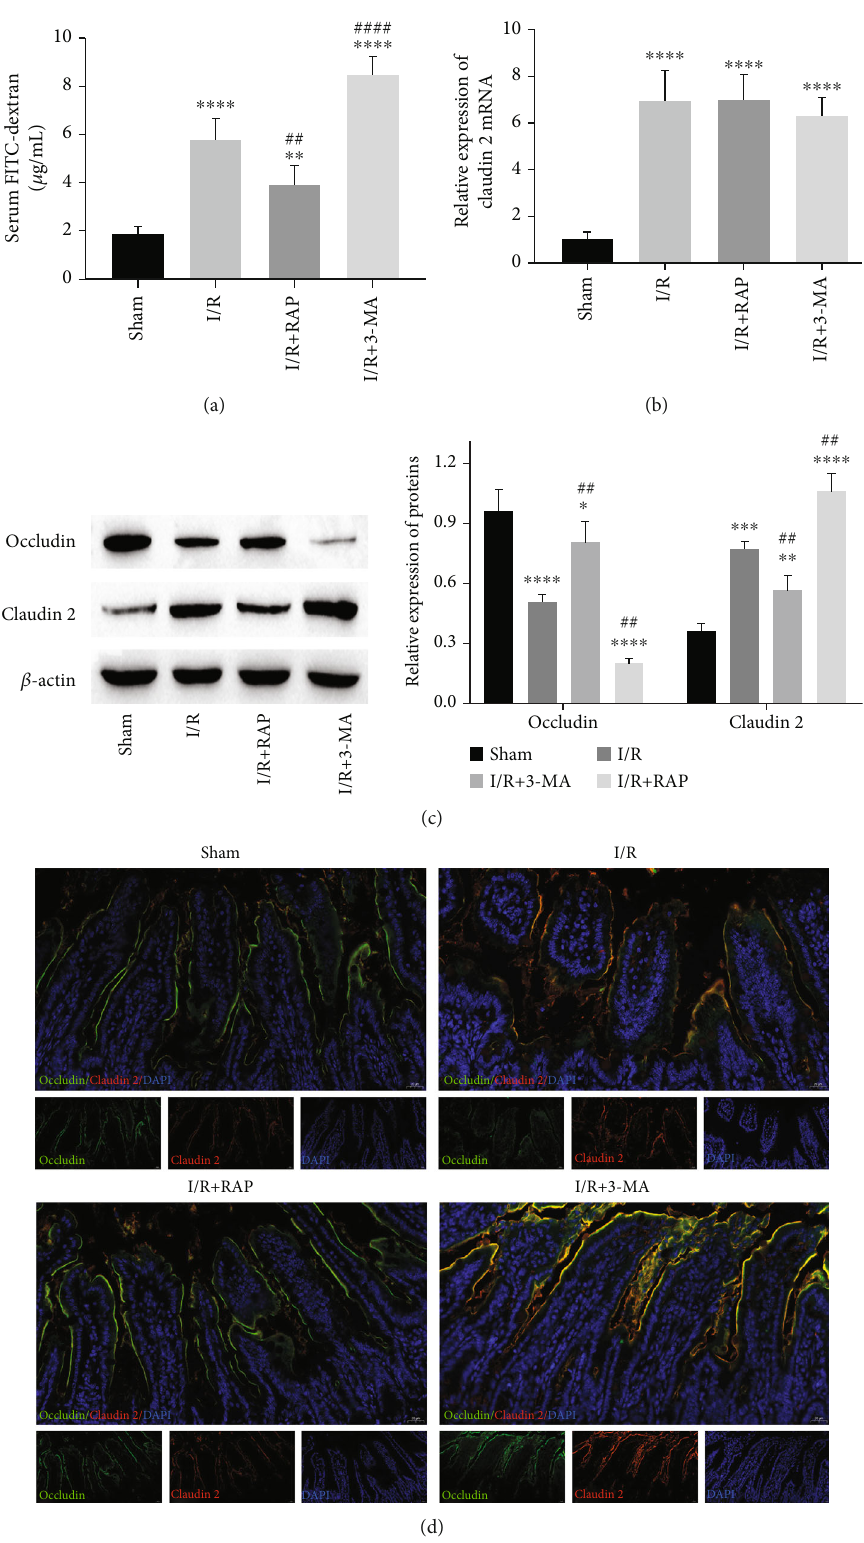
Figure 5: The e ff ects of 3-MA and RAP on the epithelial barrier after intestinal IRI. (a) The change in intestinal permeability was detected by the concentrations of serum FITC-dextran. (b) The relative level of claudin-2 mRNA was measured by RT – qPCR. (c) The protein expression levels of occludin and claudin-2. (d) Representative images of occludin/claudin-2 coimmuno fl uorescence staining in the intestine after IRI. ∗ P < 0 : 05 , ∗∗ P < 0 : 01 , ∗∗∗ P < 0 : 001 , and ∗∗∗∗ P < 0 : 0001 vs. the sham group; ## P < 0 : 01 , #### P < 0 : 0001 vs. the I/R group. n = 5 per group in the sham and I/R groups, and n = 10 per group in the other